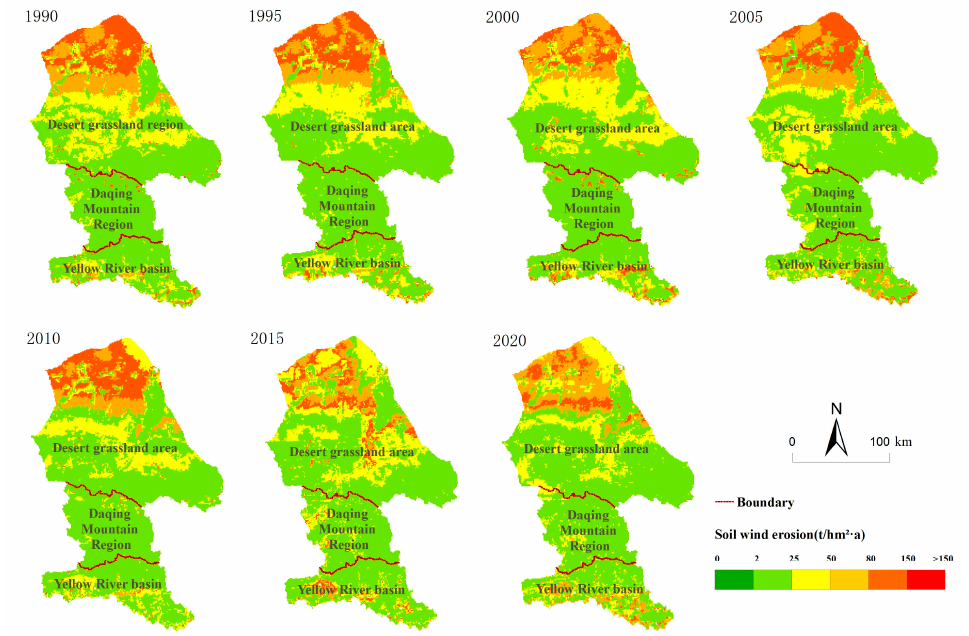
Figure 6. Spatial distribution of soil wind erosion in Baotou City.